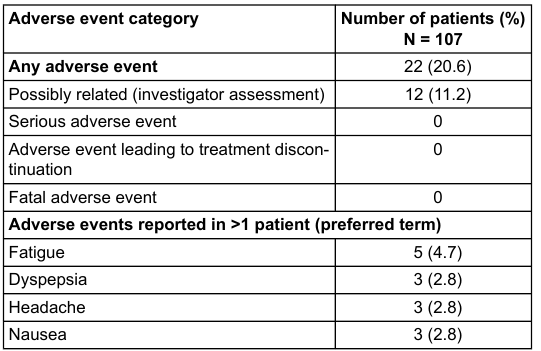
Table 4: Summary of adverse event data (safety population). Adverse event